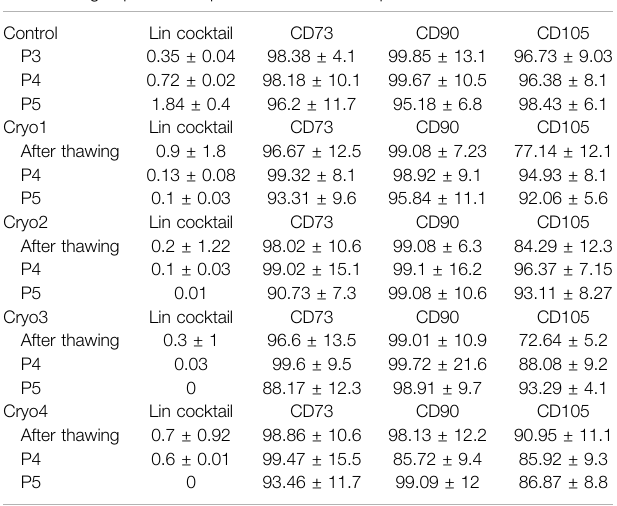
TABLE 2 | Flow cytometry of non-frozen (Control) and frozen/thawed (Cryo1 through Cryo4) AT-MSCs. The Lin cocktail contained antibodies against the CD34, CD45, CD19, CD14, HLA-DR antigens. The fl ow cytometry analysis of the surface antigen pro fi le was performed from 5 samples. Control